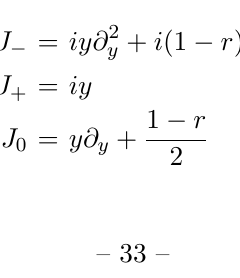
Figure 17 . Plot of values of both Re( (cid:20) ) and Im( (cid:20) ) as a function of z for r = 5 and (cid:17) the solutions merge in pairs, they move o(cid:11) into the complex